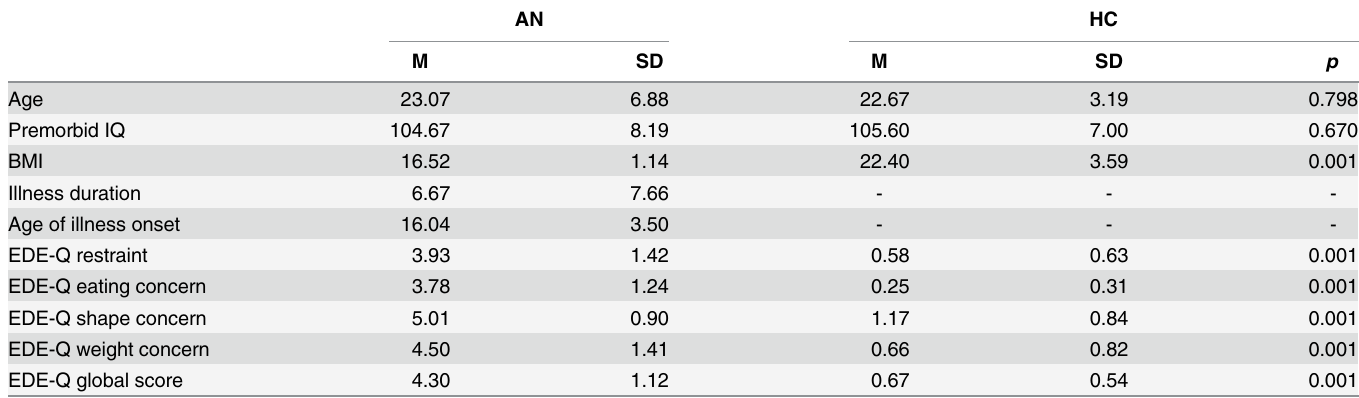
Table 1. Participant